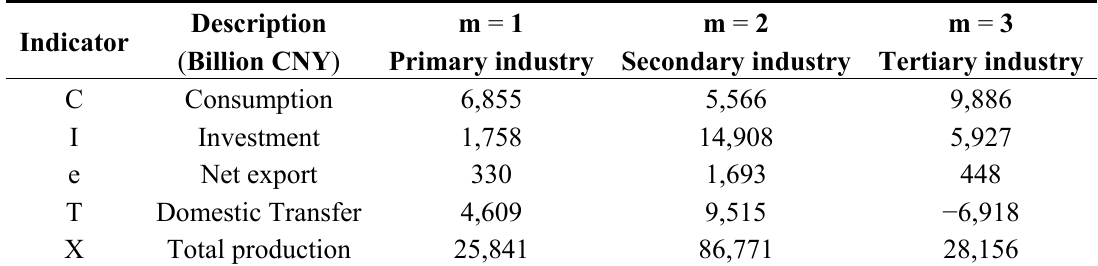
Table 2. Economic indicators and initial data in 2009.